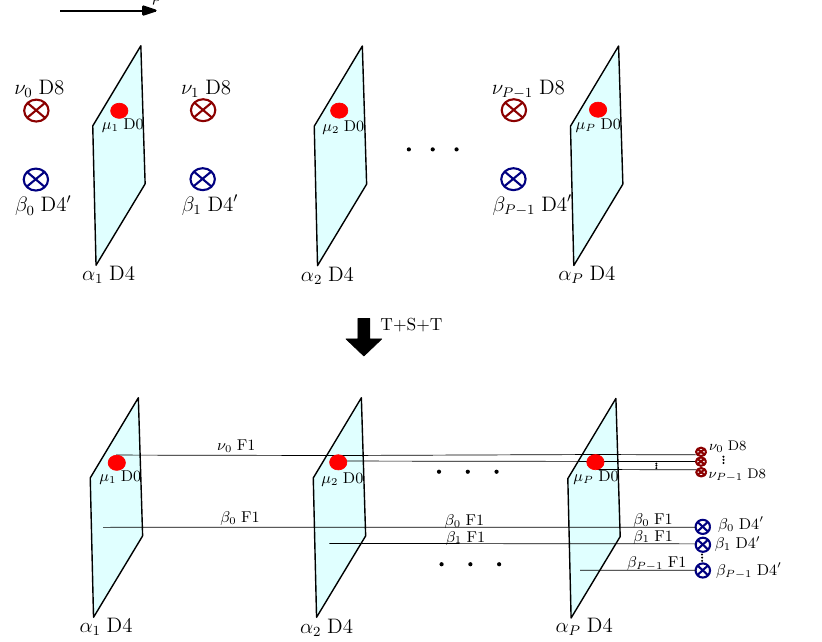
Figure 2 . (Top) Hanany-Witten like brane set-up associated with the quivers depicted in figure 1. Brane set-up equivalent to the previous one after a T+S+T duality transformation and Hanany- Witten moves